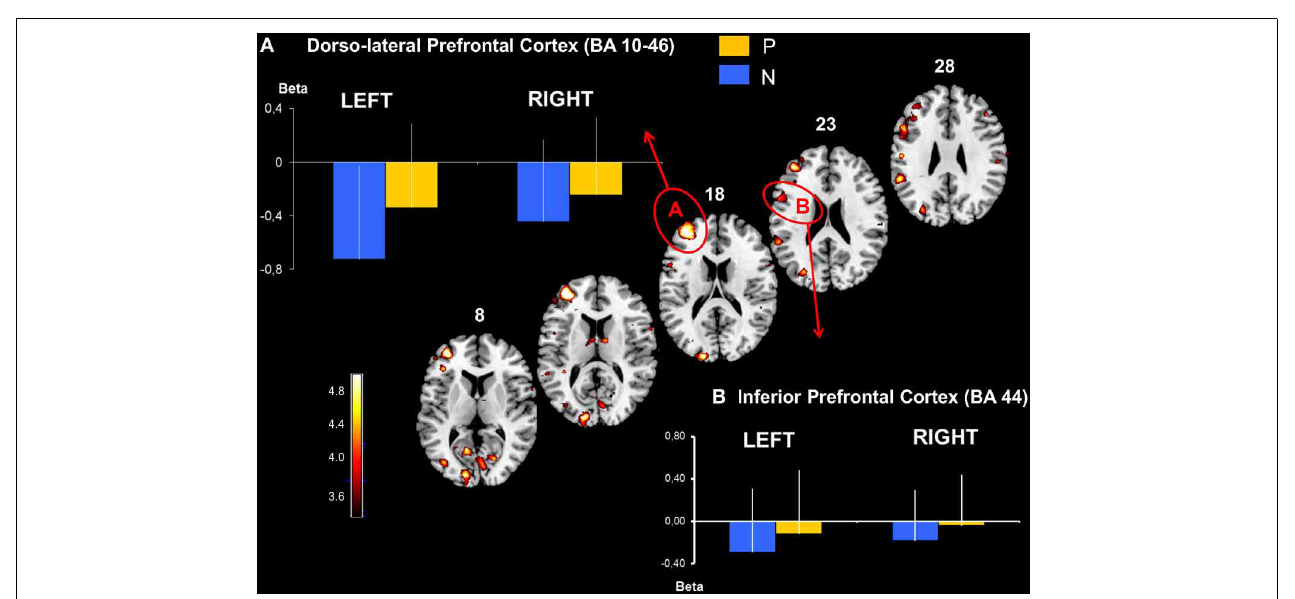
cortex, BA 40 and 7 (B) . The graphs represent mean beta values extracted at themaximalpeakofactivationduringNo-Pause(N)andPausesequences(P)in prefrontal clusters. P corrected < 0.01. Bars = standard deviations.